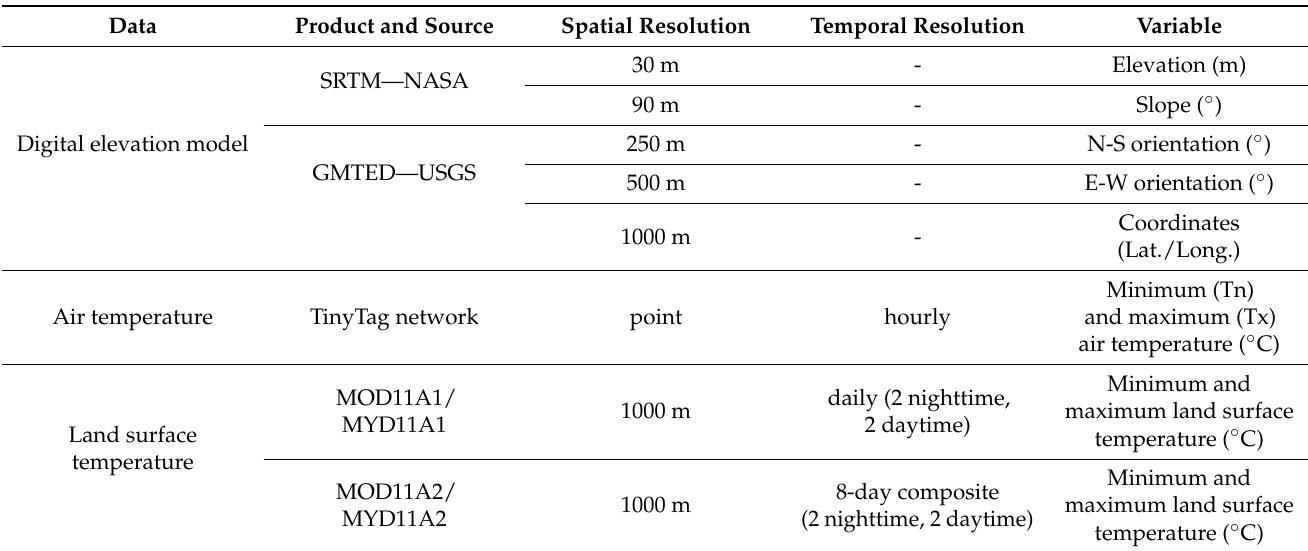
Table 1. Overview of original dataset used in the